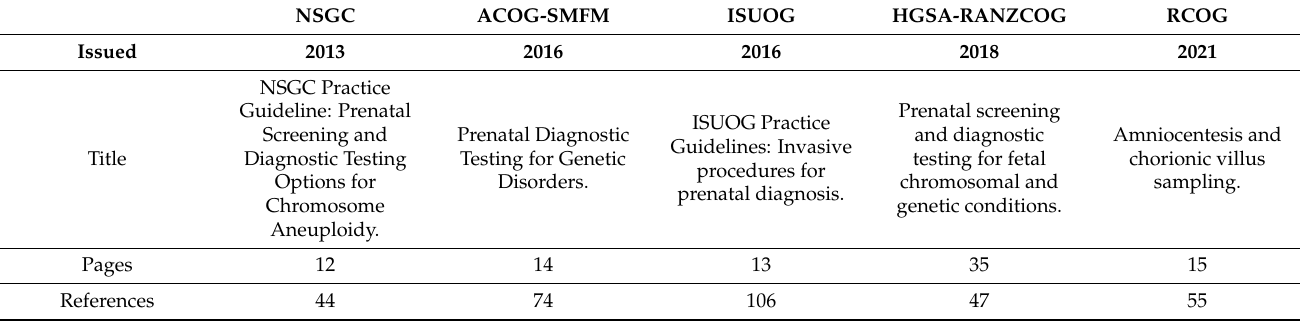
Table 1. Summary of recommendations on the indications for invasive prenatal diagnostic